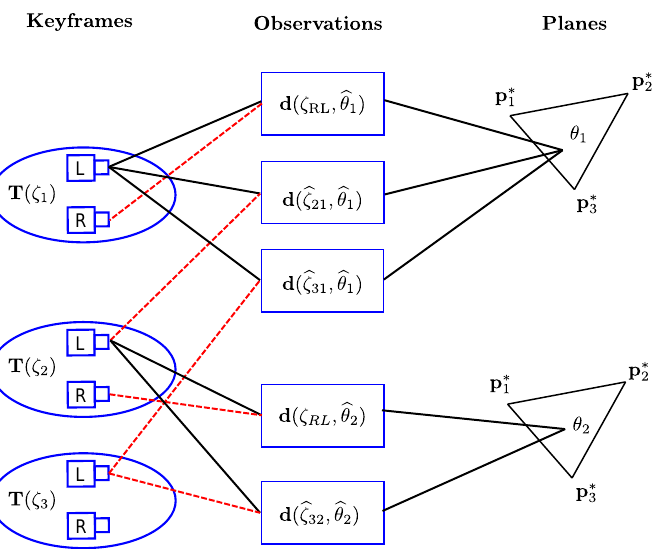
Figure 5. The example shows a sliding window with three keyframes, with poses T ( ζ 1 ) , T ( ζ 2 ) and T ( ζ 3 ) . There are two planar regions, θ 1 belonging to the first keyframe, having three observations, and θ 2 belonging to the second keyframe, having two